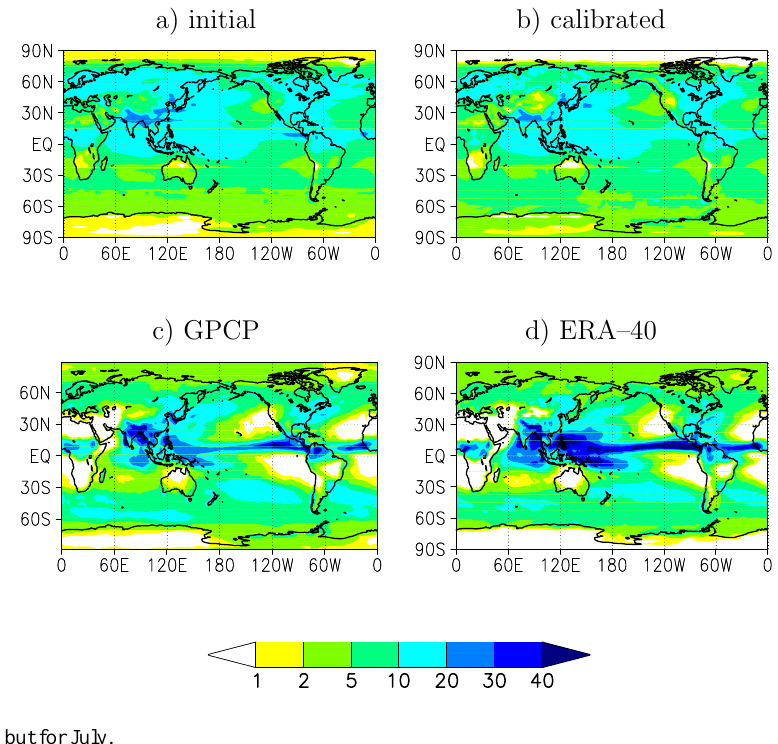
Fig. 13. Similar to Fig. 12 but for July.